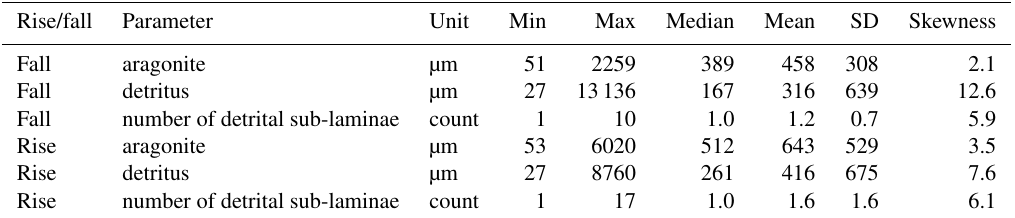
Table 1. Bulk statistical properties of the studied sedimentary series.